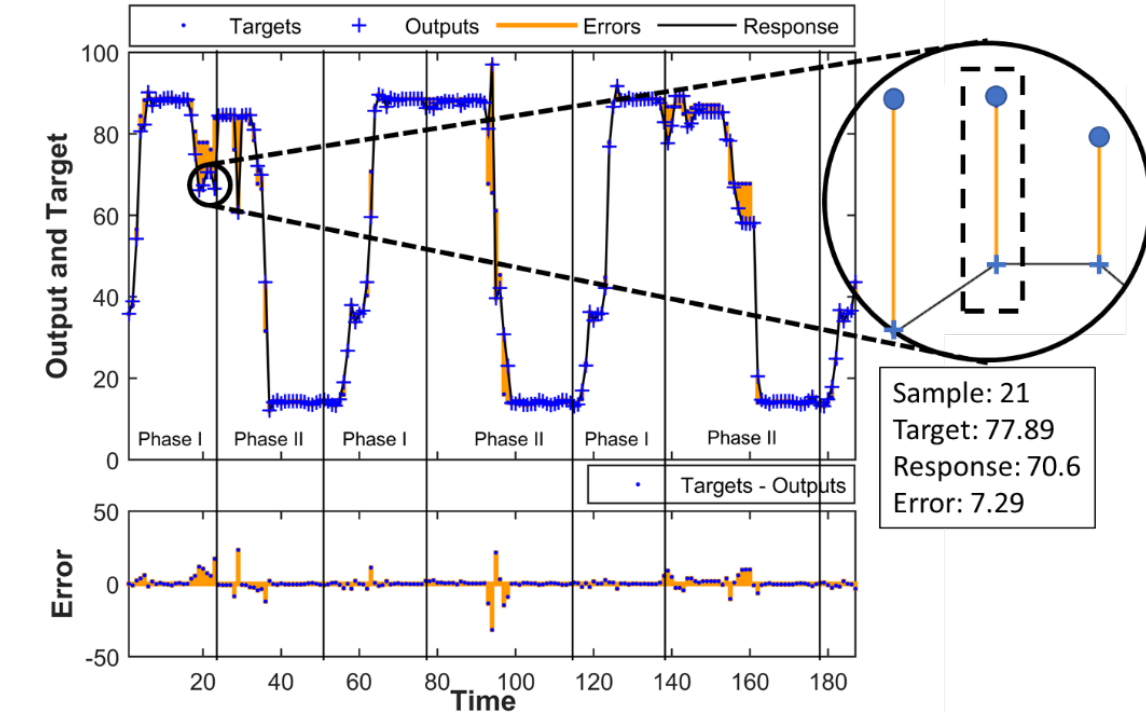
Figure 7: The output response of the NARX neural network with 15 hidden layers and delay 2, which is trained by the Bayesian